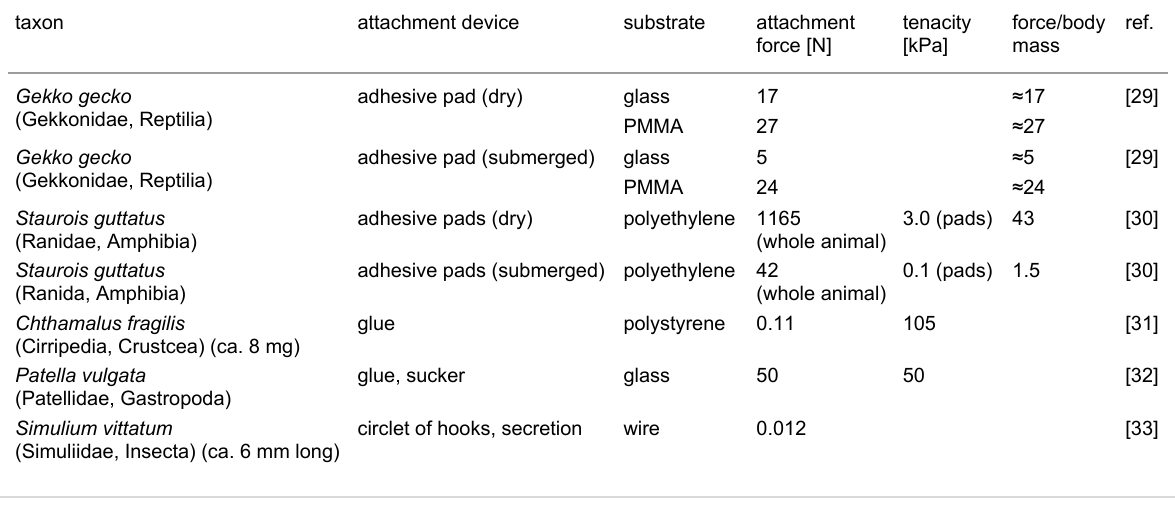
Table 5: Examples for attachment parameters measured perpendicular to the substrate according to different authors (whole animal, on smooth sub- strates at water level and terrestrial environment, respectively).